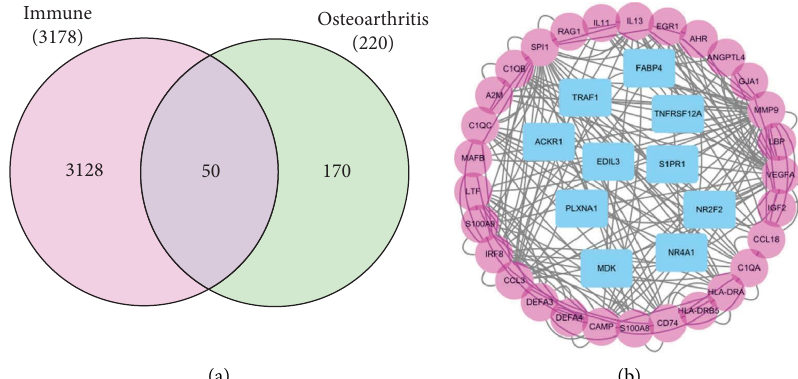
Figure 2: (a) Te Venn diagram demonstrated the genes that are closely associated with DEGs and immune-related genes. (b) Te PPI network based on the 50 key